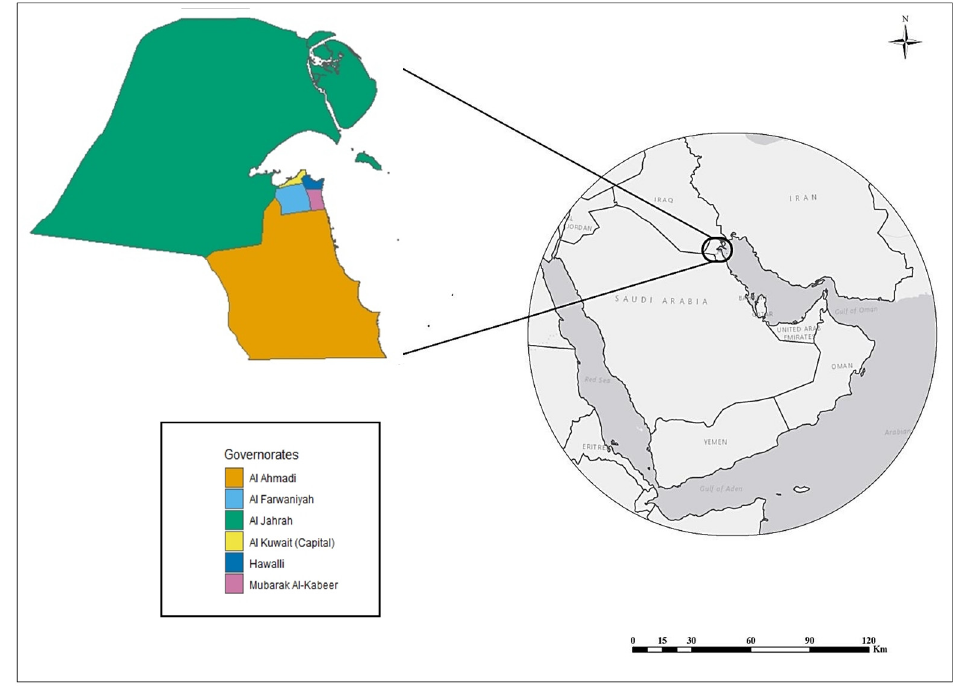
Figure 1. Map of Kuwait and Kuwait’s six governorates.